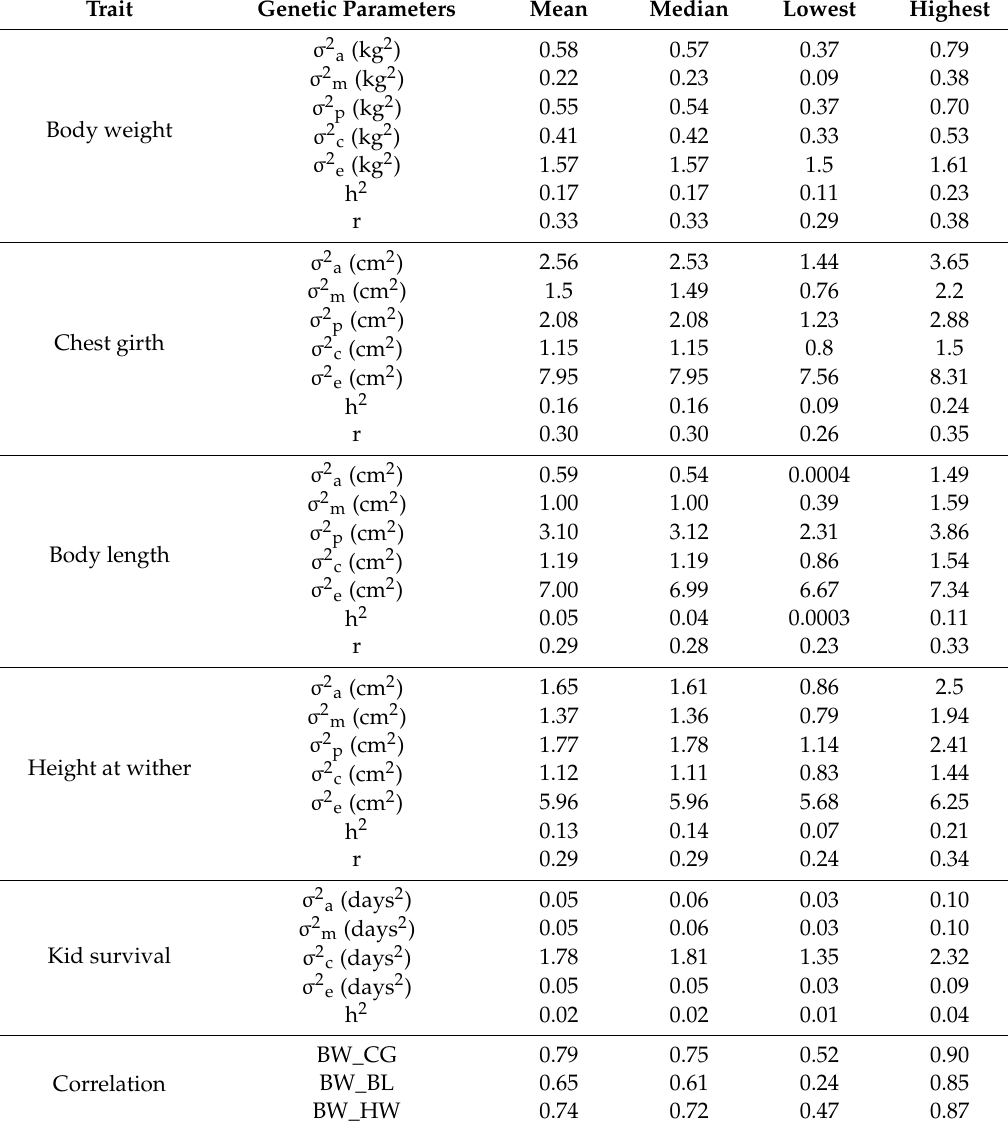
Table 2. Mean, median, and highest posterior density (HPD) lowest and highest limits for genetic parameters of body weights, chest girth, body length, height at whither, and survival up to 12 months: additive ( σ 2 a ), maternal ( σ 2 m ), permanent environmental ( σ 2 p ), and common environmental ( σ 2 c ) variance components; repeatability (r) and heritability (h 2 ) and genetic correlations between body weight and chest girth (BW_CG), body weight and body length (BW_BL), and between body weight and height at wither (BW_HW). Trait Genetic Parameters